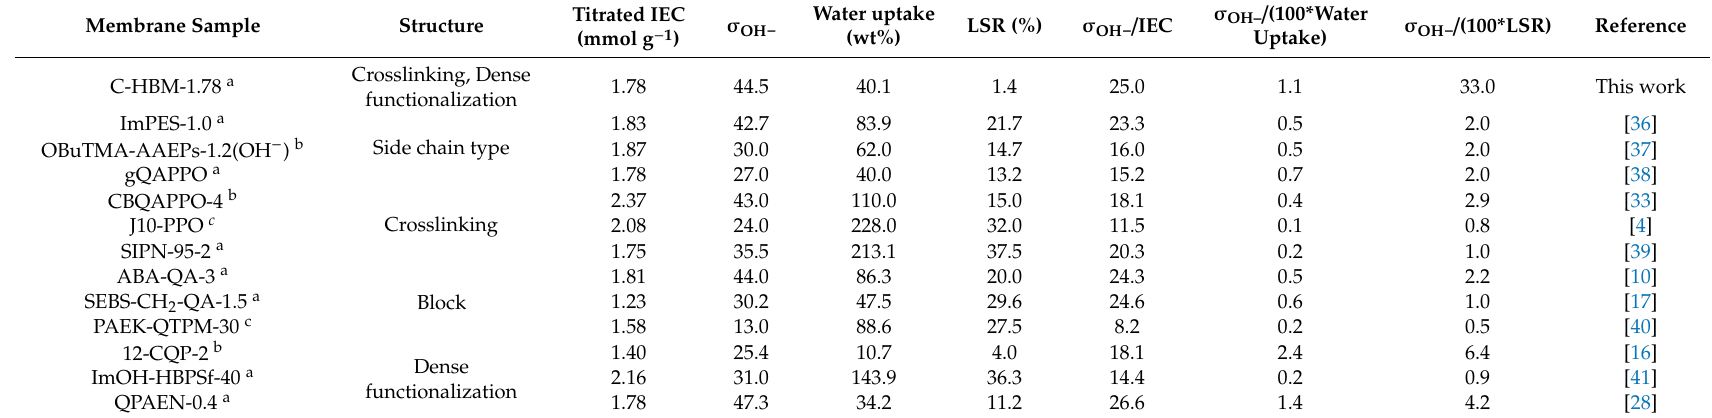
Table 1. Comparison regarding ion exchange capacity (IEC), hydroxide conductivity, water uptake, and linear swelling ratio (LSR) of C-HBM-1.78 with reported membrane